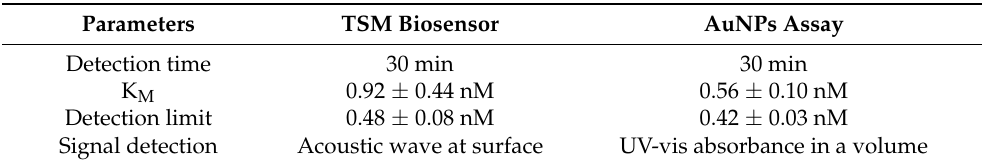
Table 1. Comparison of TSM biosensor and AuNPs platform (colorimetric biosensor) used for detection of